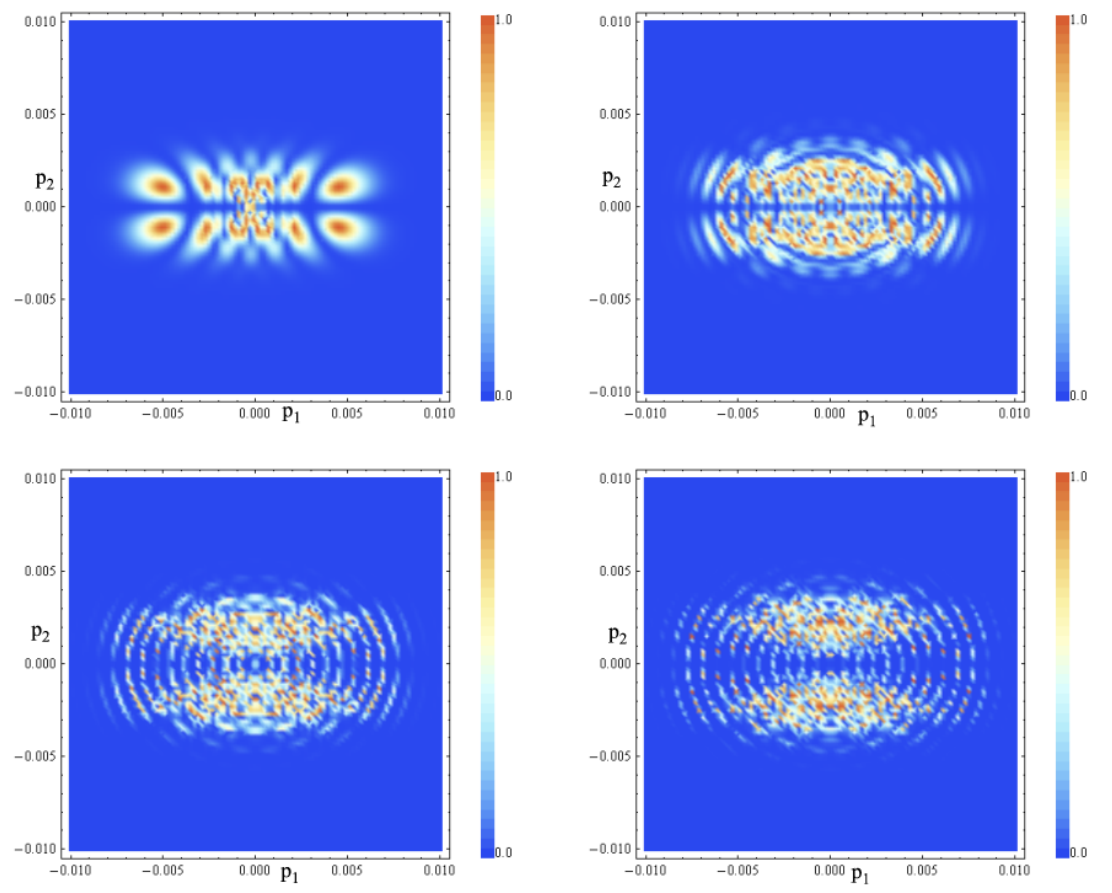
Figure 9. The residual distribution function under the action of the field of type (60) with the frequency 1.0 THz, amplitude E a = 1000 V/cm and σ =